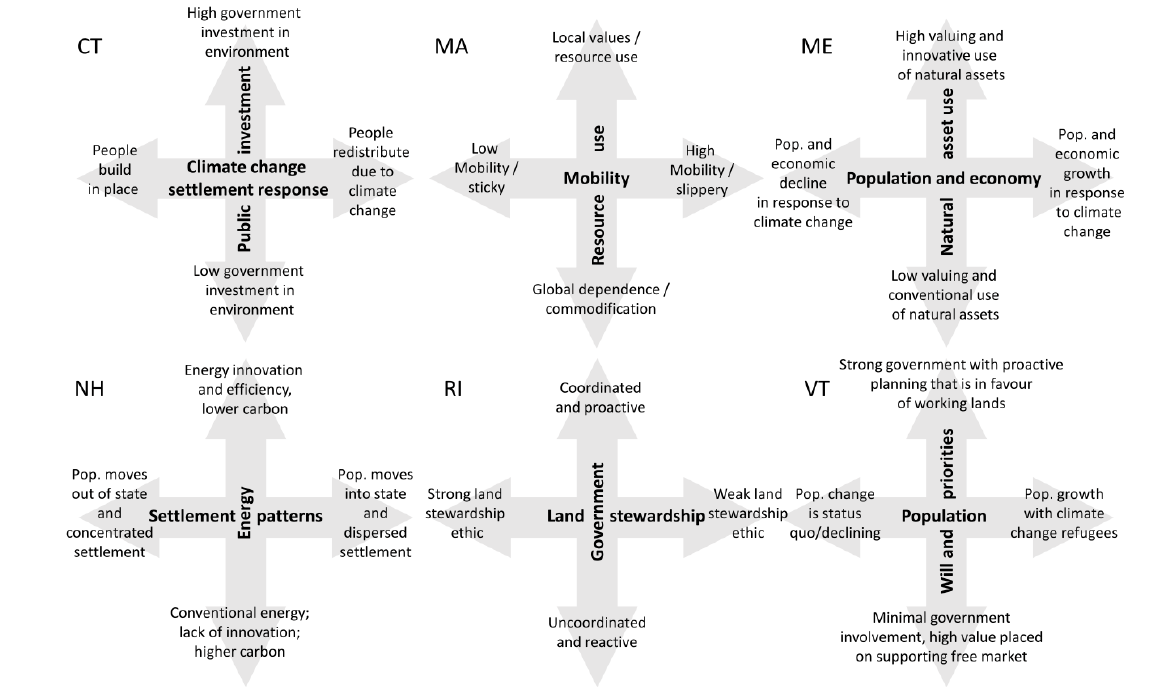
Fig. 2 . The scenario matrices (i.e., axes and endpoints) developed at each of the six New England state